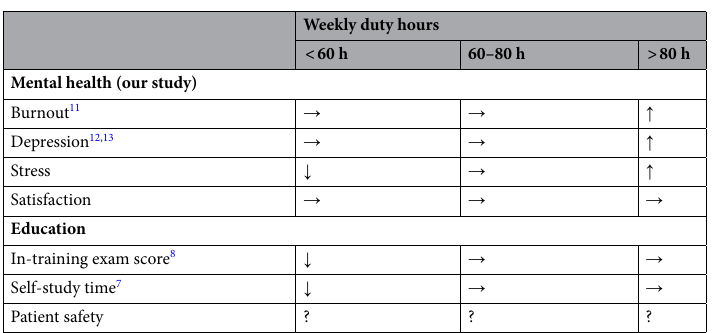
Table 4. The summary of evidence related to duty hours and postgraduate residents in Japan. This table shows the factors associated with duty hours of postgraduate residents in Japan. Using 60–80 h weekly (equivalent to 80–120 h of overtime per month) as a reference point, the table shows how these factors change when working less than 60 h weekly or more than 80 h weekly. The references corresponding to each item are presented in the